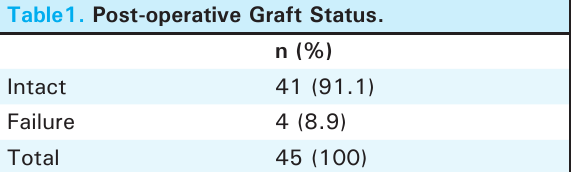
Table1. Post-operative Graft Status. n (%) Intact 41 (91.1) Failure 4 (8.9)